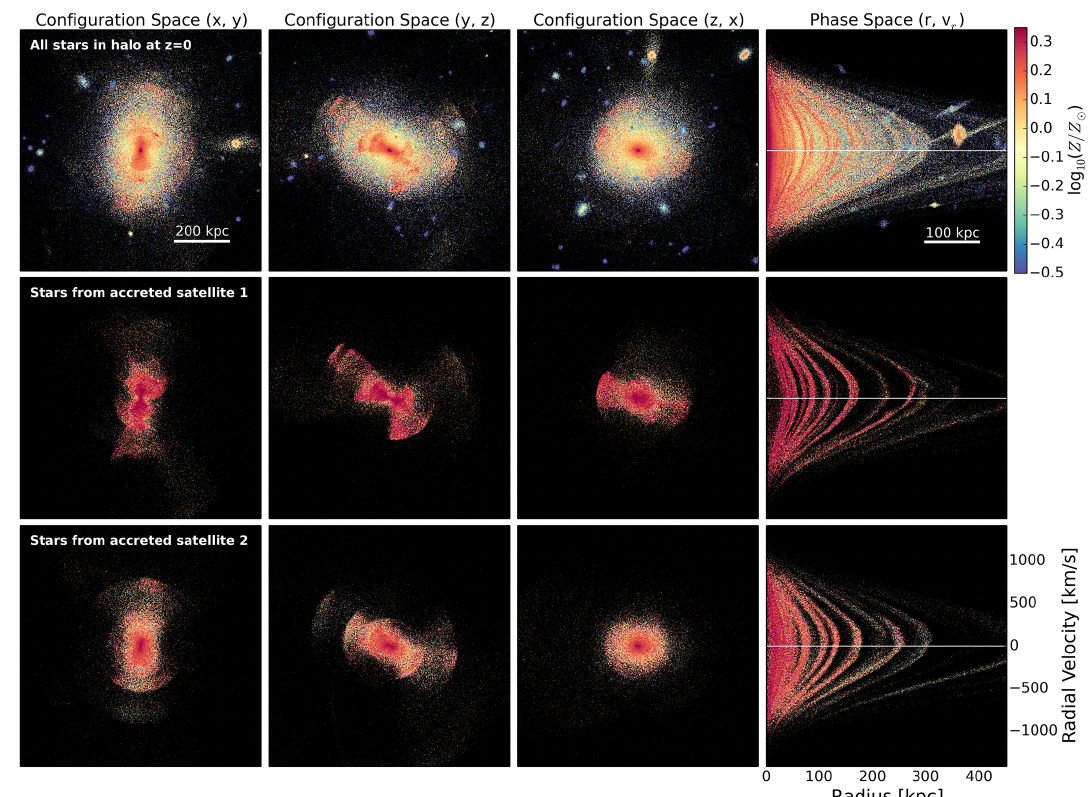
Figure 2. Stellar maps in configuration space (first three columns) and phase space, i.e., radial velocity vs. radial distance (last column). The color of each bin of area A bin = ( 1.5kpc ) 2 in the 2D histograms above corresponds to the median total metallicity (Z) of all star particles therein. Top row : entire halo of a z = 0 shell galaxy with total stellar mass M stars = 1.3 × 10 12 M (cid:12) , virial mass M 200crit = 4.6 × 10 13 M (cid:12)